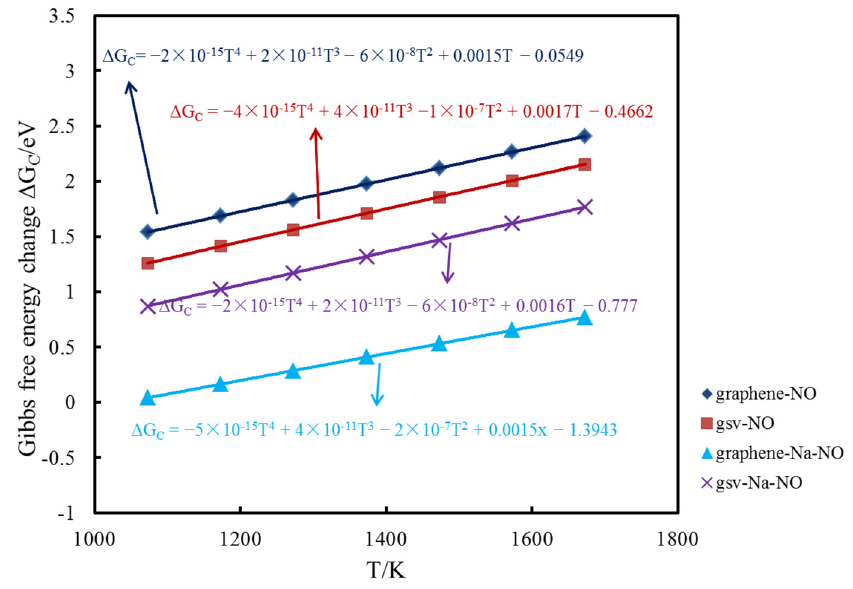
Figure 6. The formulas of Gibbs free energy change under different temperatures.